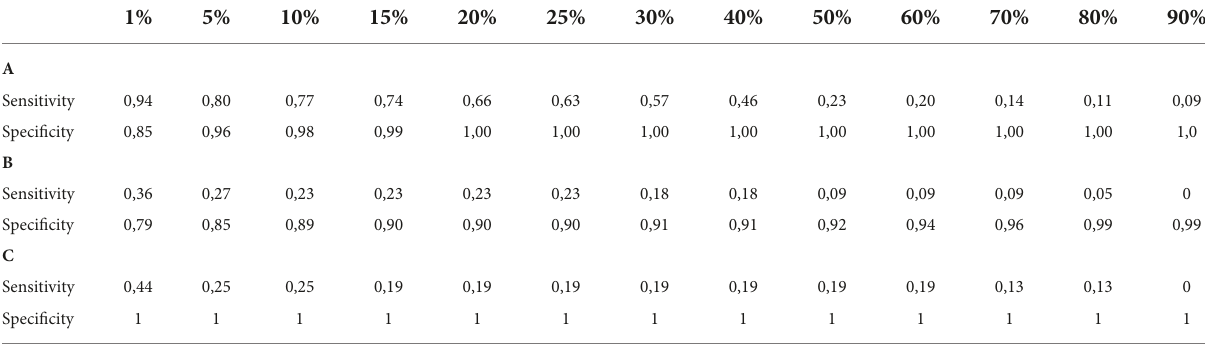
TABLE 2 The sensitivity and specificity values are listed in this table at each threshold level of the three example cases.